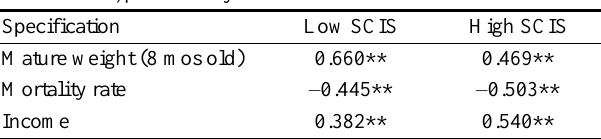
Table 5. Pearson correlation between stockmanship competence index scores, productivity and